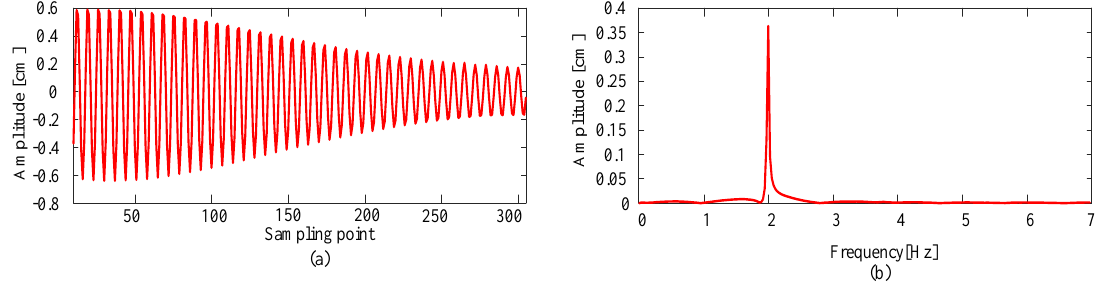
Figure 14. Processed result of the measurement data. ( a ) The vibration curve of the contact wire after removing clutter. ( b ) The corresponding frequency distribution of the processed curve.